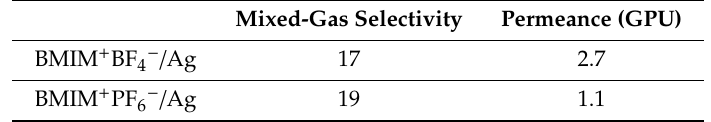
Table 1. Separation performance of BMIM + BF 4 − / Ag and BMIM + PF 6 − / Ag composite membranes.